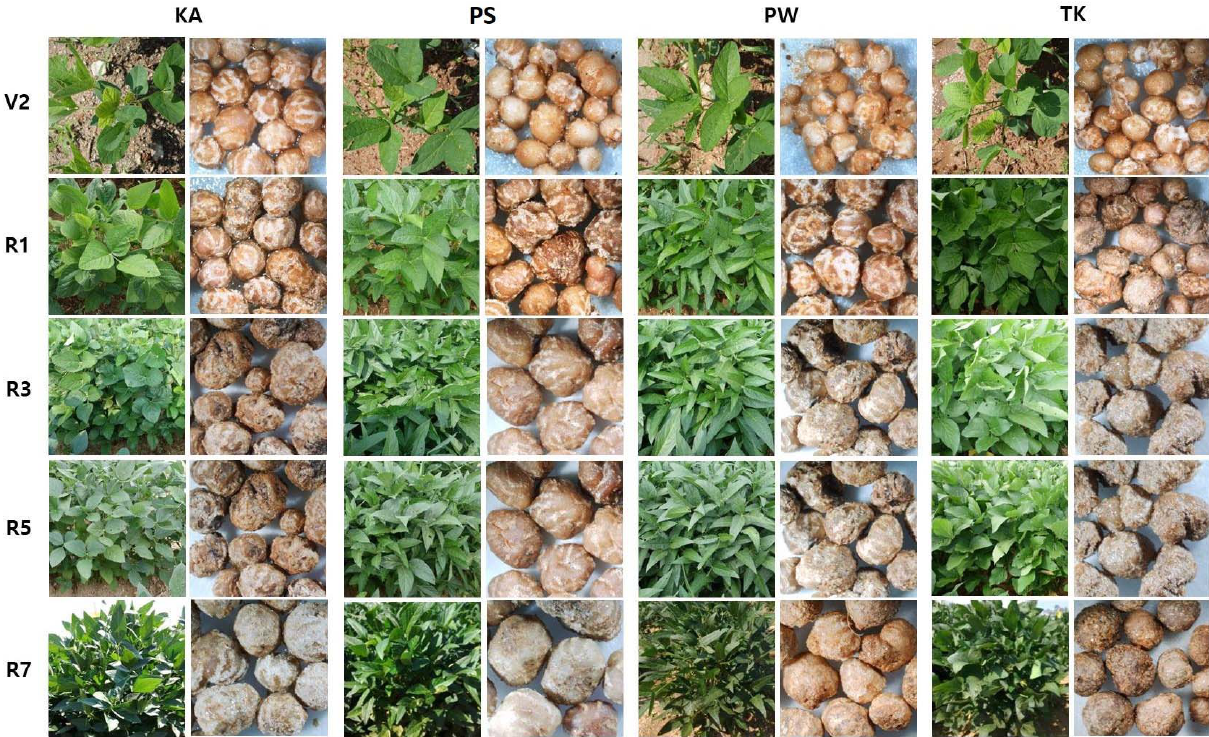
Figure 1. Morphology of four varieties of plants and root nodules based on the various growth stages (V2. R1, R3, R5, R7) of soybean. KA, Kwangan; PS, Poongsannamul; PW, Poongwon; TK, Taekwang.